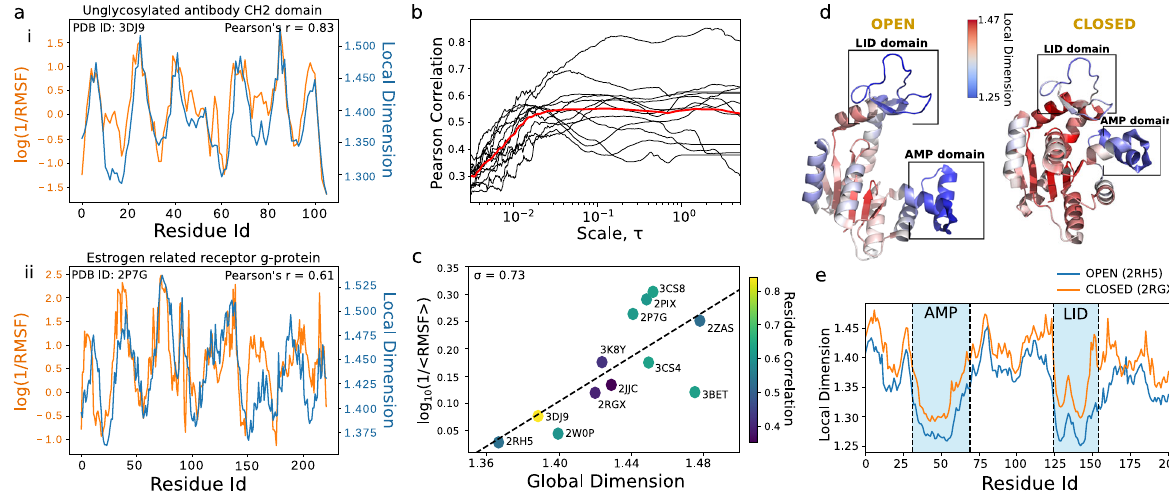
Fig. 4 The relationship between root-mean-square fl uctuations (RMSF) of protein residues and their local and global dimension. a The log-inverse RMSF vs local dimensionality for each residue in i unglycosylated antibody CH2 domain, ii Oestrogen Related Receptor g. b The positive correlation (0.539) between local dimension and log-inverse RMSF at the residue level across 12 different proteins as a function of scale. c A strong positive correlation between global dimensionality of 12 proteins against log-inverse RMSF. d The local dimension of each residue mapped onto Aquifex Adenylate Kinase in the open (PDB ID: 2RH5) and closed (PDB ID: 2RGX) conformations and e plotted by residue id.